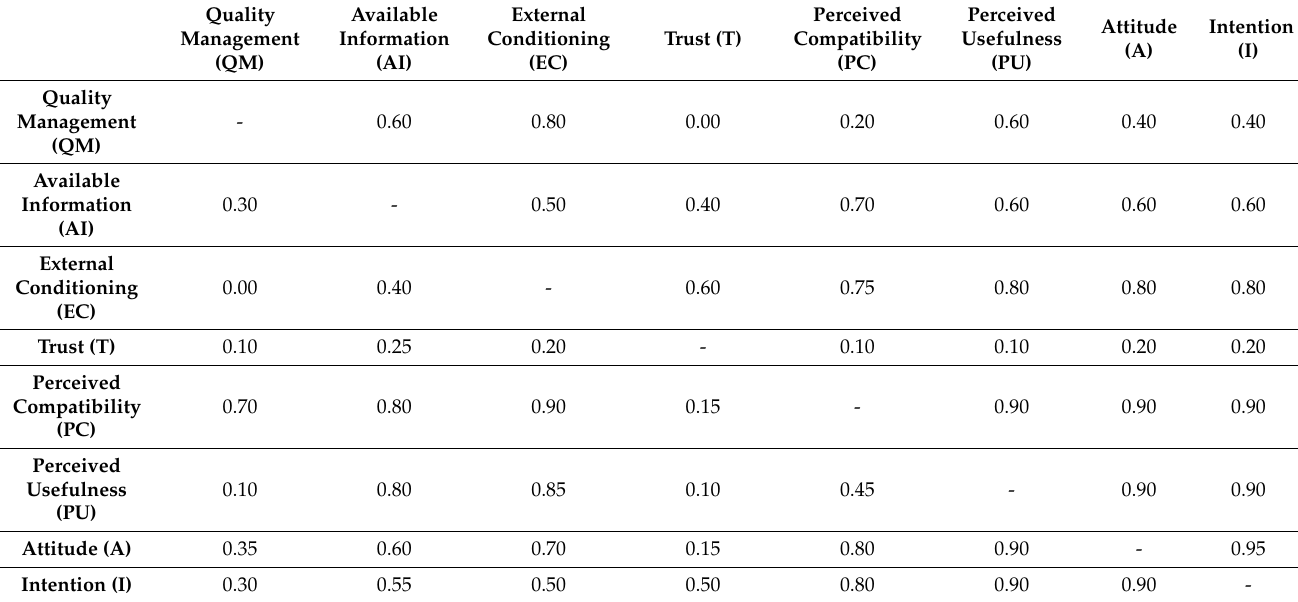
Table 3. Adjacent matrix of the collective fuzzy cognitive map.